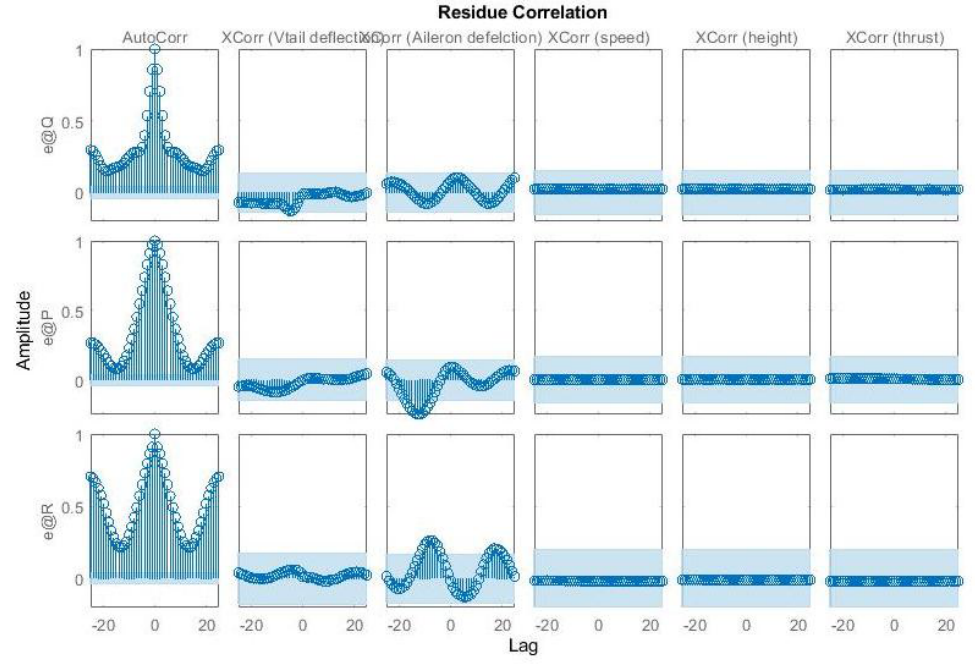
Figure 17. OE Model Residue Correlation.